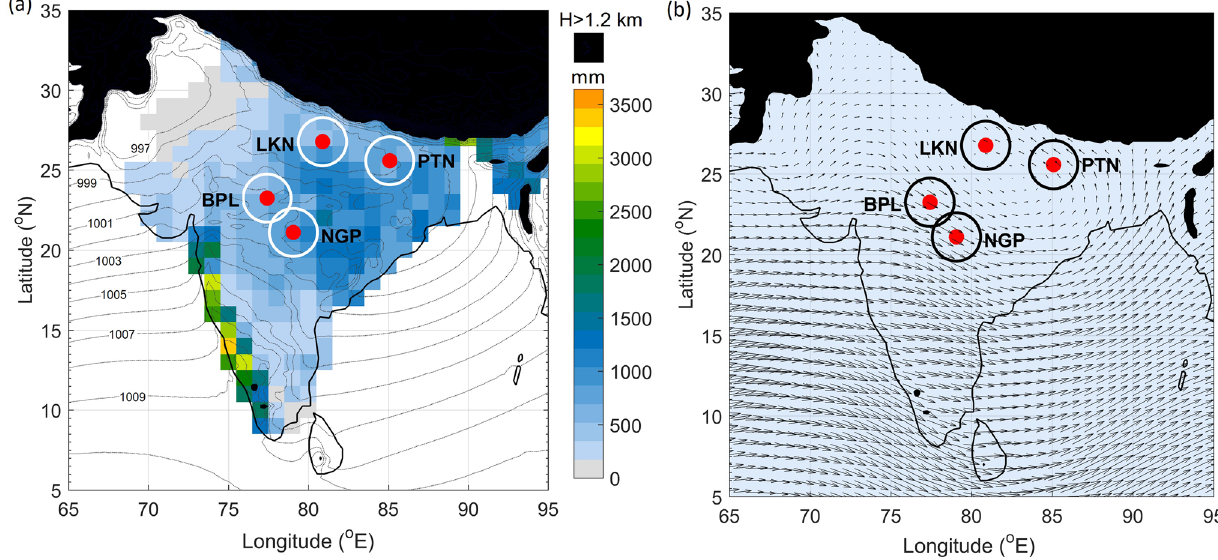
Figure 1. Geographical locations of S-band Doppler weather radars included in the study: (1) Lucknow (LKN; ◦ ◦ ◦ ◦ 26.77 N, 80.88 E, 143 m), (2) Patna (PTN; 25.58 N, 85.08 E, 67 m), (3) Bhopal (BPL: 23.24 ◦ ◦ m), (4) Nagpur (NGP; 21.09 N, 79.06 E, 335 m). ( a ) June to September average rainfall (mm) based on 1 gridded rainfall dataset of IMD for the period 1951–2003 is overlaid. The curves onto rainfall patterns are the mean sea level (in hPa) pressure from the ERA5 dataset for July during the years 1979–2018. Grids with surface elevation > 1200 m are masked as shown in the black patch. The outer circle around each DWR location